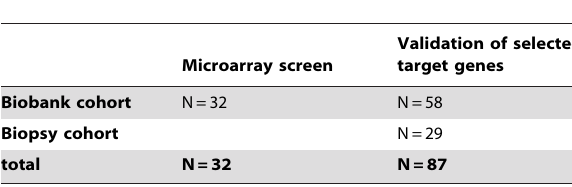
Table 4. Overview of samples applied to screening and validation of deregulated genes in steatohepatitis and